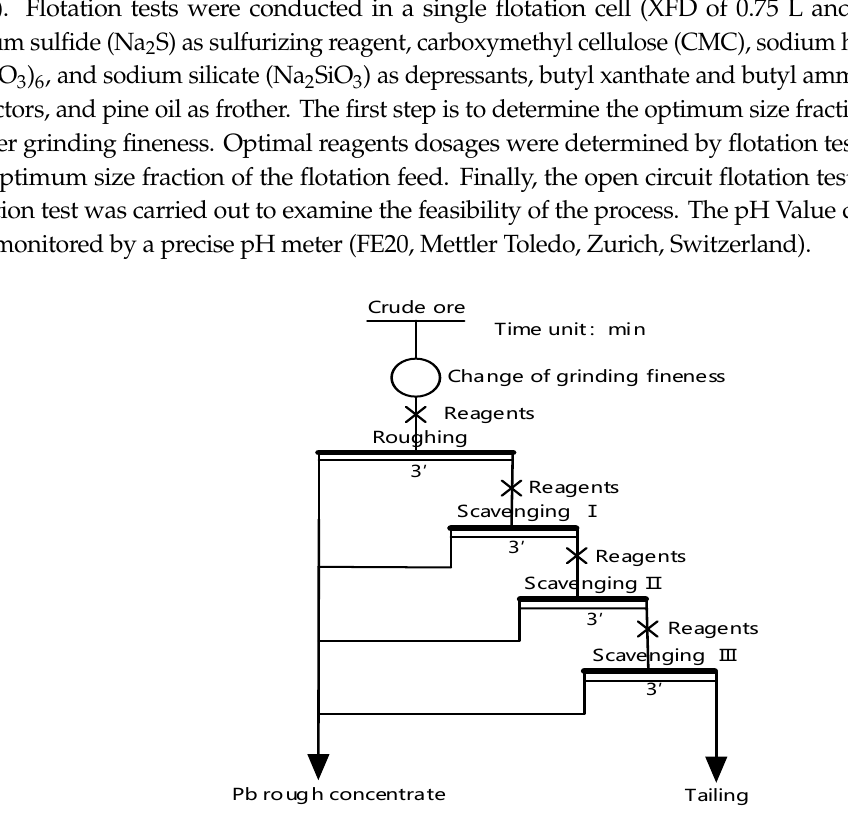
Figure 1. Flow chart of tests to determine the grinding fineness and reagents’ dosage.